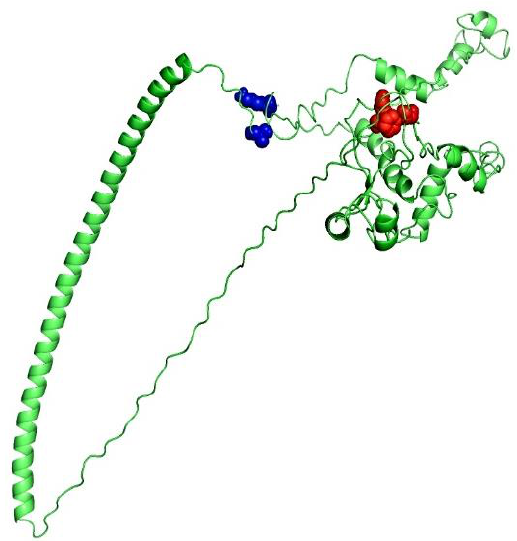
Figure 4. To improve the stability of the MEV, disulphide engineering was performed. The green color represents vaccine structure whereas the blue and red colors represent the two mutated pairs, selected on the basis on the X 3 and B-factors.